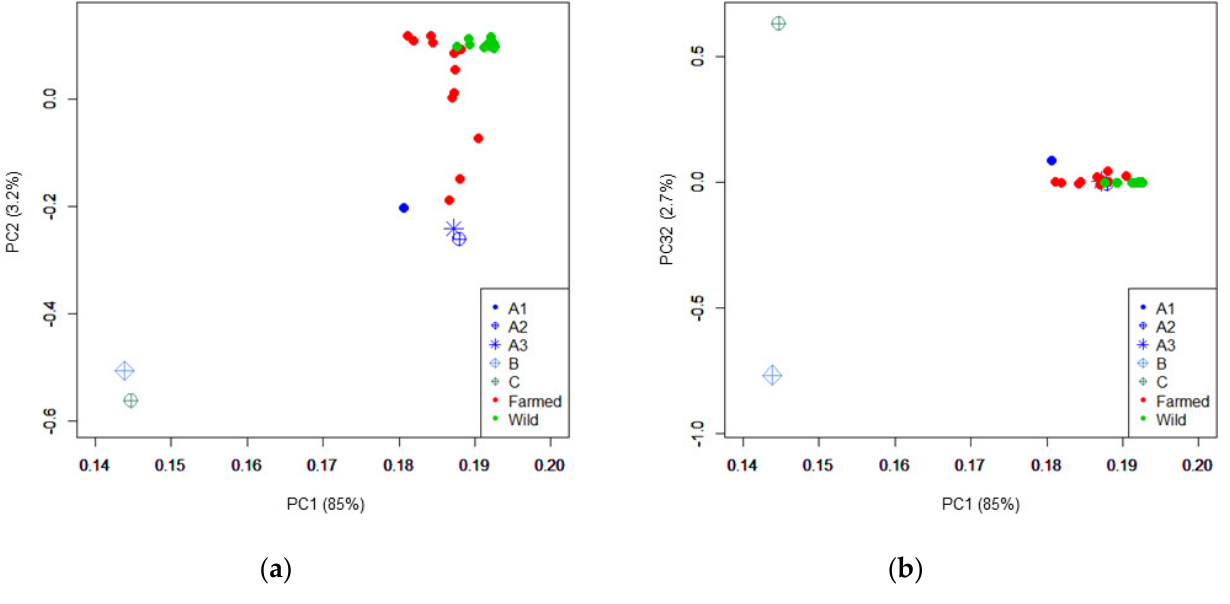
Figure 1. PCA obtained plots of the gilthead seabream populations and nuclei investigated in this study. The first three Principal Components (PC) are reported with the explained variation in parentheses. The three subpopulations of offspring derived from the same nucleus (A1, A2, and A3) are all labelled in blue but indicated with di ff erent marks. ( a ) PC1 1 and PC2; ( b ) PC1 and PC3.